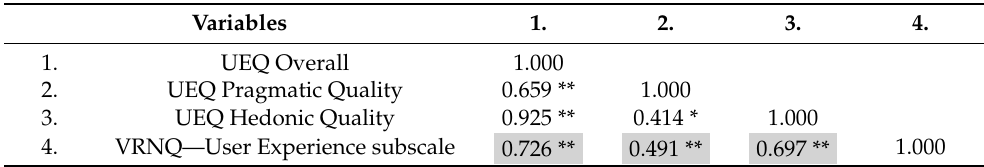
Table 15. Correlation matrix for LA_RFH condition—Spearman ( ρ ) correlation coefficients for combined user experience measures ( n = 4).